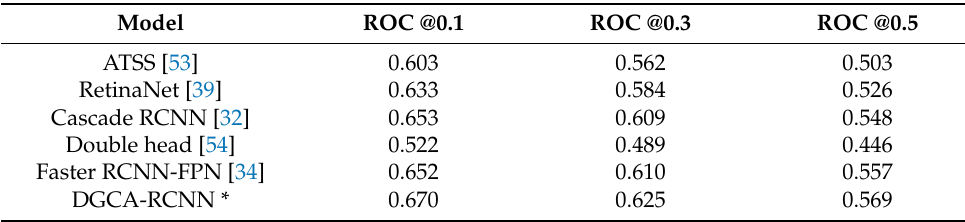
Table 5. The AUC results for the ROC curves at three different IOU thresholds.